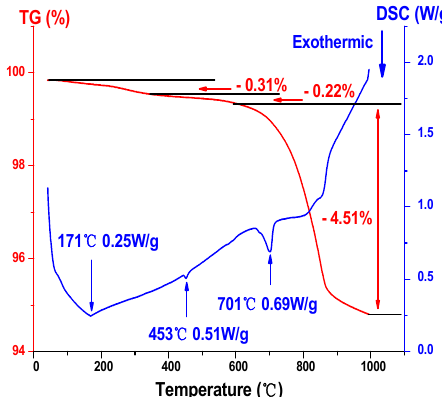
Figure 3. TG–DSC curves for a 1% Ni-doped sample.